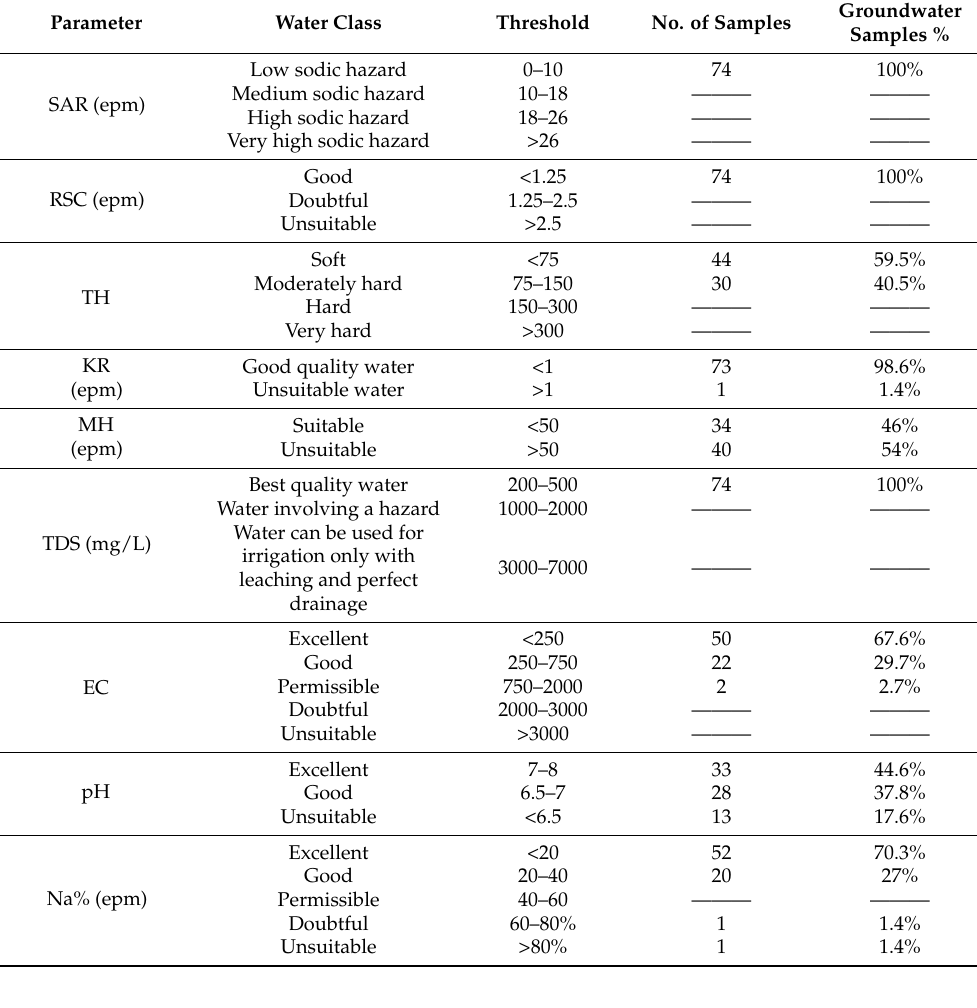
Table 5. Physicochemical data of irrigation groundwater samples based on various parameters.